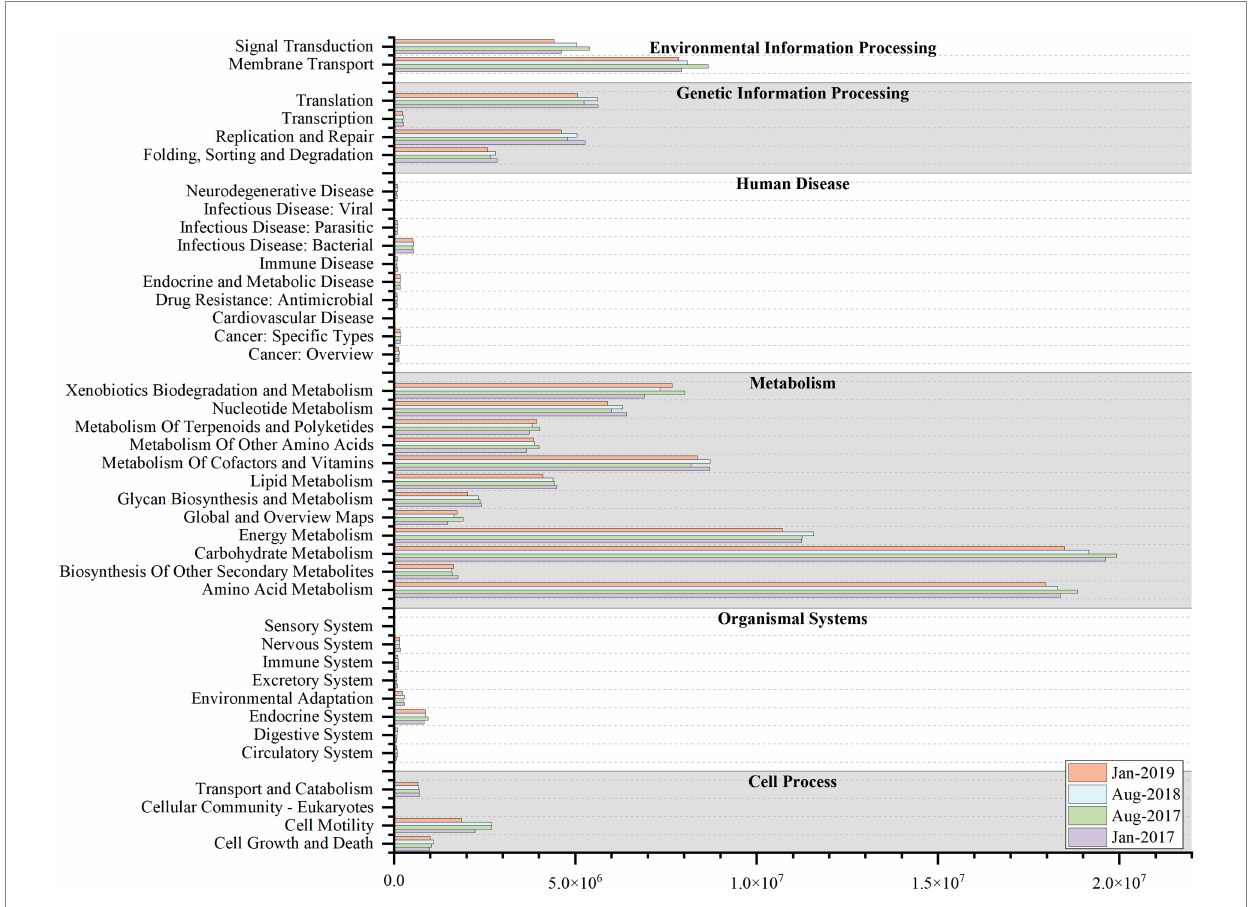
FIGURE 6 The Kyoto Encyclopedia of Genes and Genomes (KEGG) functional profiling at level-2 at four sampling time (Jan-2017, Aug-2017, Aug-2018 and Jan-